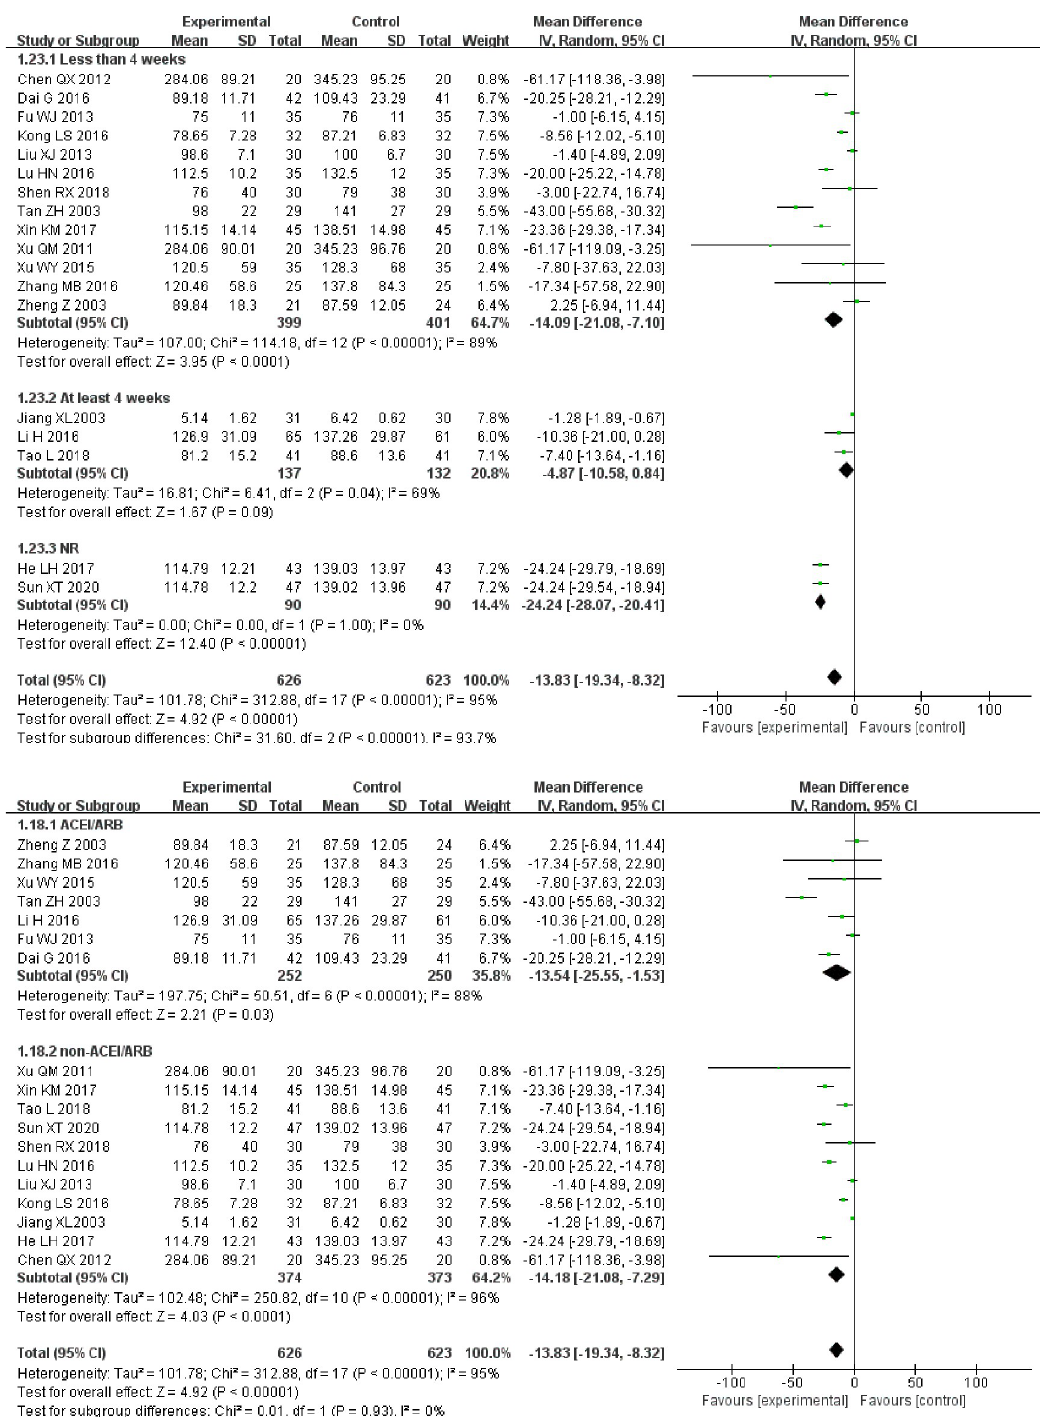
Fig 6. A. Forest plot of SCr subgroup analysis based on treatment duration. B. Forest plot of SCr subgroup analysis based on treatment measures.